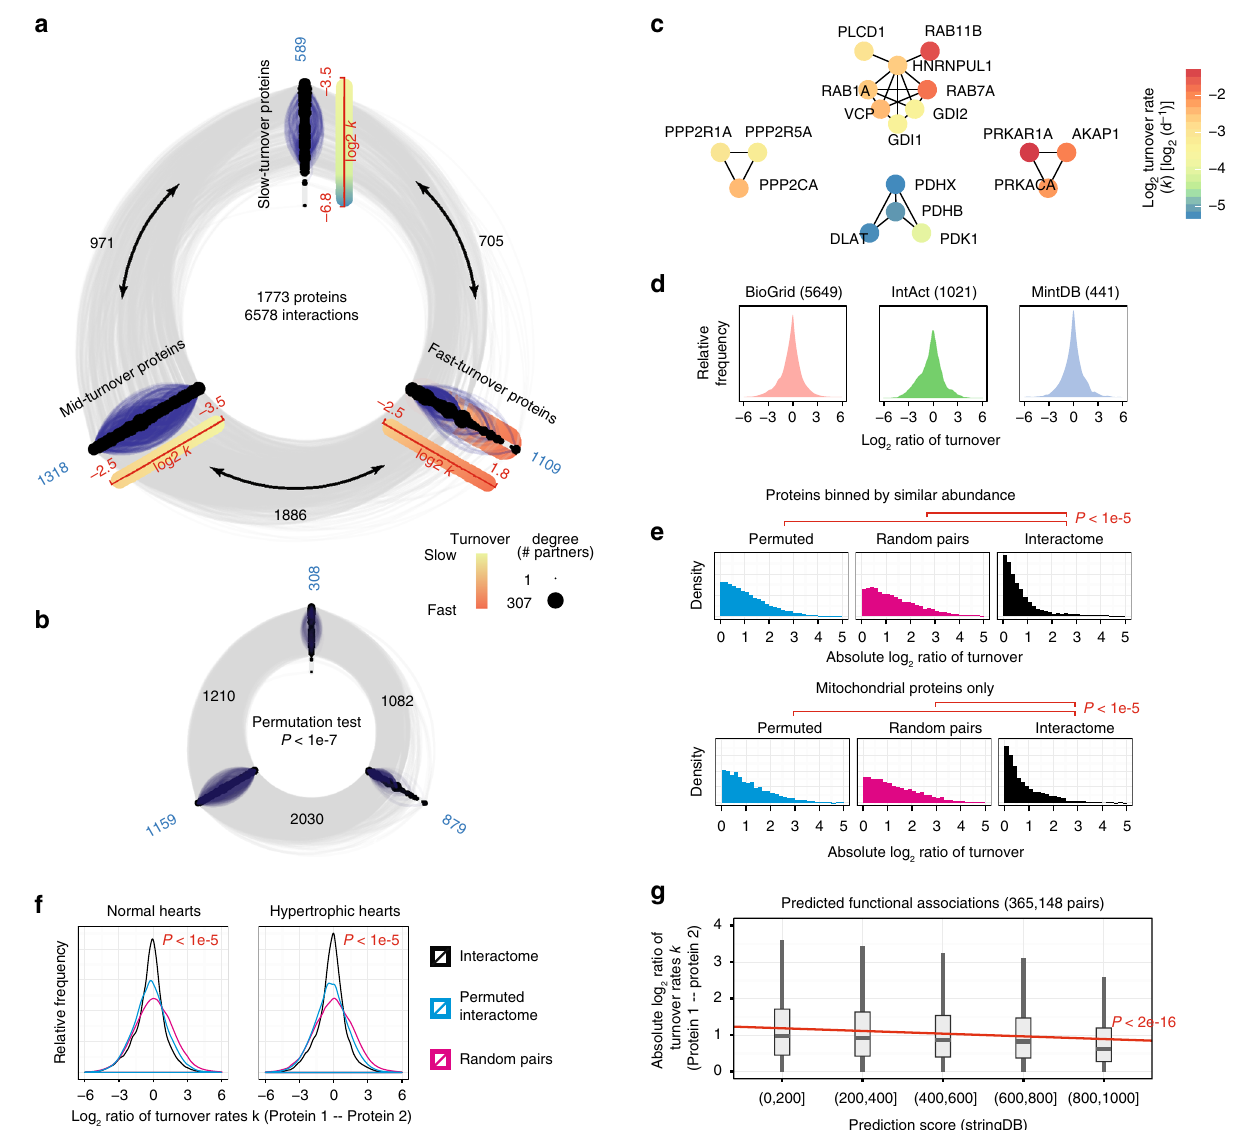
Fig. 6 Protein – protein interacting partners are coordinated in turnover. a Network diagram of 6578 annotated protein – protein interactions involving 1773 anotated proteins with turnover rates measured in ≥ 4 mouse strains, retrieved from three databases (BioGrid, IntAct, and MintDB). Protein nodes in the network are grouped by turnover rates and aligned along three axes (slow, mid, and fast). Edges: interactions between two proteins in the same (blue) or different (gray) turnover rate groups. Numbers denote the number of interaction edges within each group (blue) and between groups (black). Radius of protein nodes: degree of interacting partners. b Permutation means of inter-group and intra-group connections, showing that interactions preferentially occur among proteins with similar turnover rates ( P < 1e-7 from 1e7 permutations). c Selected examples of interacting proteins with similar turnover. d Interacting partners have signi fi cantly more similar turnover, from the data individually curated in each of the 3 queried databases. e Distribution of log 2 protein turnover differences in interaction partners, random pairs, and permuted pairs, controlling for the effect of protein abundance by including only a bin of 250 proteins with moderate abundance (relative abundance 2 – 11.9 – 2 – 10.7 ). The 250 proteins formed 2043 interactions, with 1.26-fold average turnover differences vs. 1.88-fold in random pairs (permutation test P < 1e-5). Interacting partners likewise have similar turnover when only mitochondrial proteins are analyzed to control for the effect of subcellular localization (permutation test P < 1e-5). f Distribution of log 2 turnover ratios between retrieved interacting partners (black), random pairs of analyzed proteins (magenta), and randomly resampled interaction pairs (blue) (permutation test P < 1e-5) in normal and hypertrophic hearts. g Differences in protein turnover rates ( y -axis) are correlated with the predicted interaction score between two proteins on STRING ( x -axis), with every 1-fold difference in turnover reducing the score by 22 (linear regression P < 2.2e-16). High-con fi dence predicted associations (scores of 800 – 1000) are particularly more similar in turnover than protein pairs in other bins (Kruskal – Wallis test with post hoc P < 2.2e-16). Box: 25th to 75th percentile; whiskers: 5th to 95th